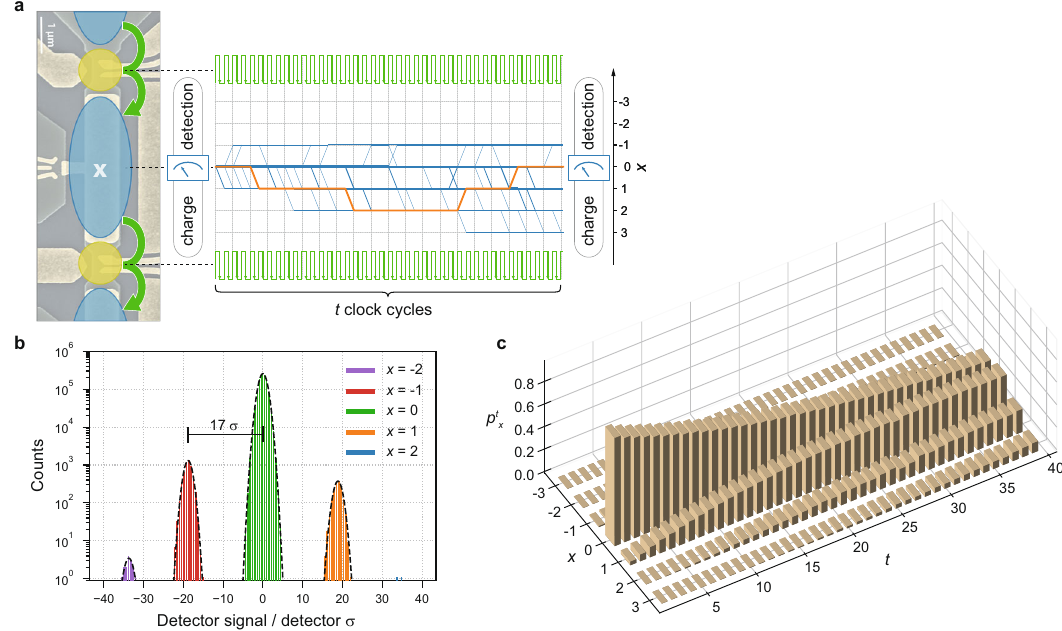
Fig. 1 Schematic of the random-walk benchmark for single-electron transfer utilizing charge counting. a Sample micrograph and measurement scheme. After the initial charge measurement t clock cycles are applied. The paths taken by 30 simulated walkers (using error rates extracted from the counting statistics) are represented by blue lines, transitioning every clock cycle in x by a step of − 1, 0, + 1. The frequency with which each branch is visited is indicated by the linewidth. A fi nal charge measurement yields the end-point of the random walk as the difference between initial and fi nal charge. The orange line exempli fi es a single random walk with self-intersections. b Signal to noise ratio: a (typical) histogram of the differential charge detection signal with the identi fi ed difference in electron number indicated by color. The peak separation is shown in units of the Gaussian noise amplitude σ (black dashed lines indicate the corresponding Gaussian fi ts). c Measured statistics of fi nding the walker at position x after t